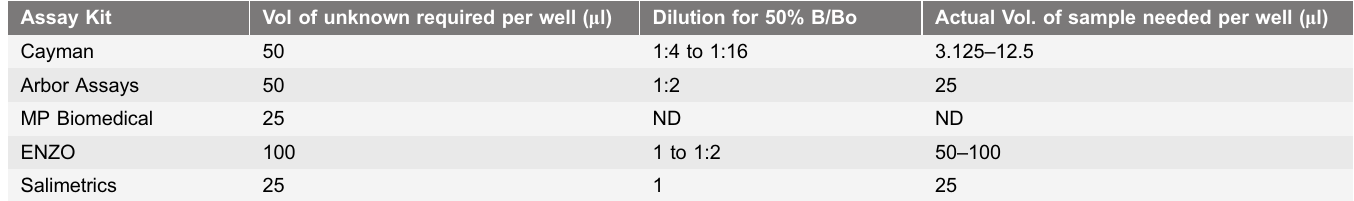
Table 1. Calculated volumes of blow required per well to reach 50%B/Bo (the middle of the standard curve) for each cortisol EIA tested. Assay